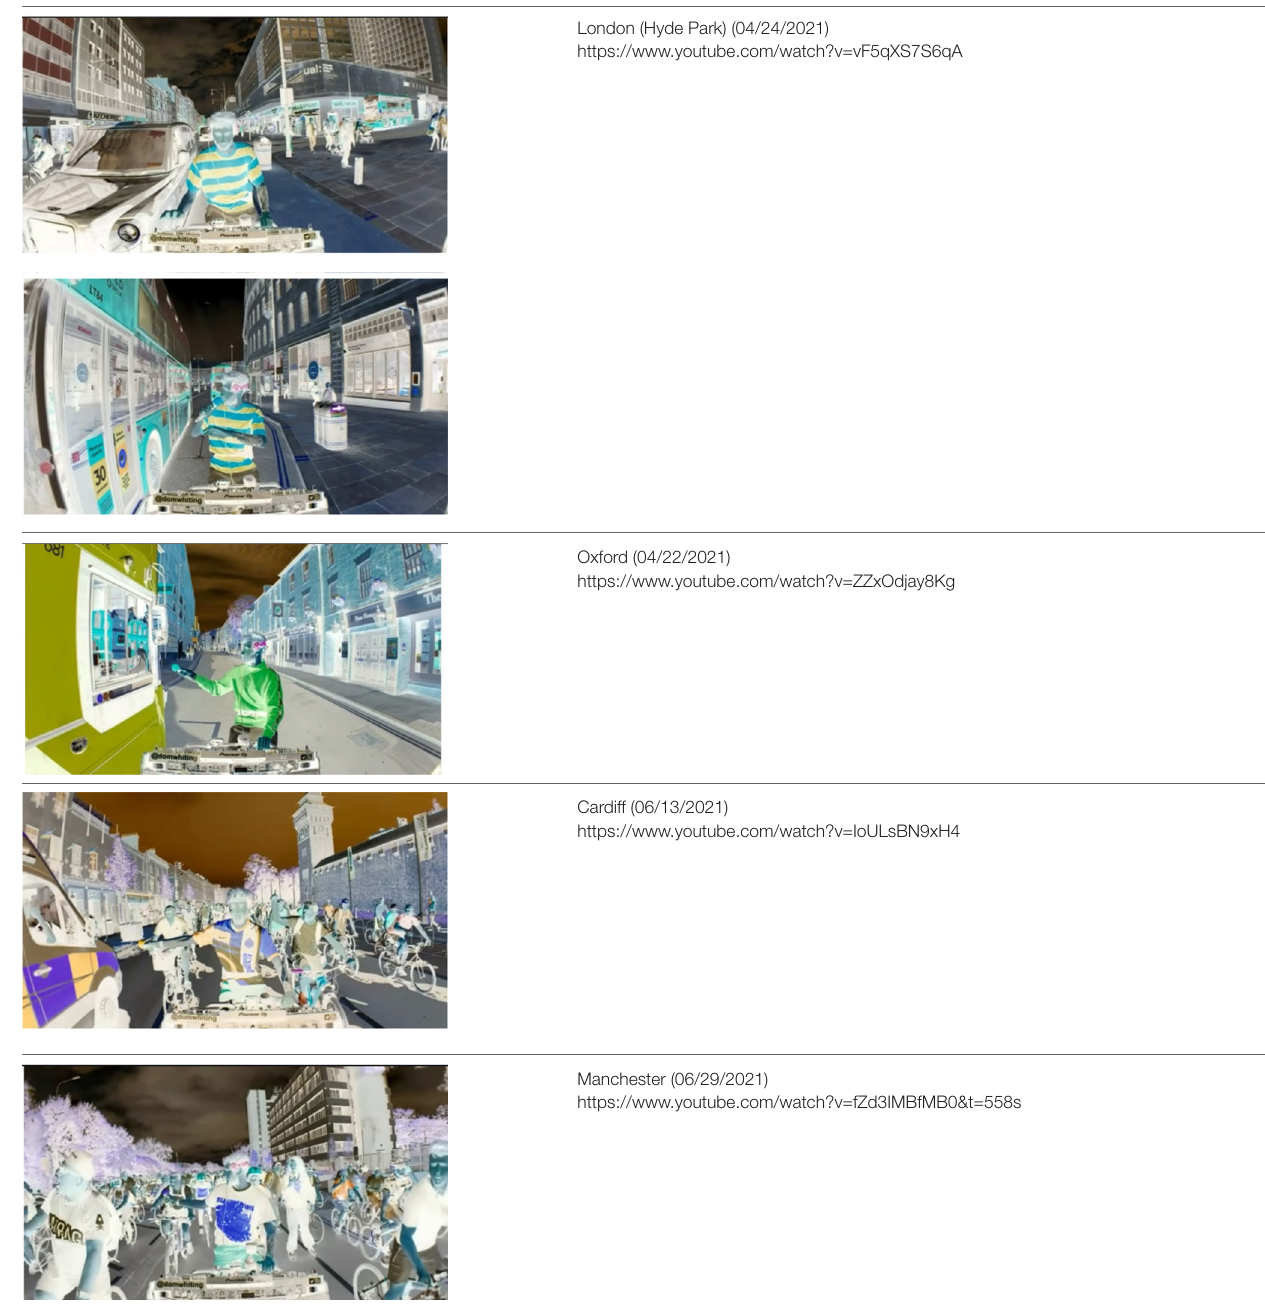
TABLE 2 | Reconfiguration of the relationship between motor vehicle drivers and